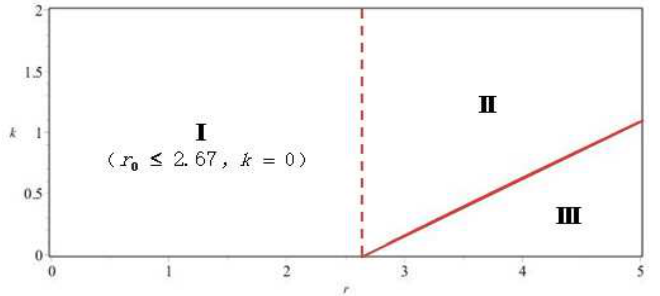
Figure 7. The stability region of E ∗ in r 0 − k parametric space. Other parameters are given in